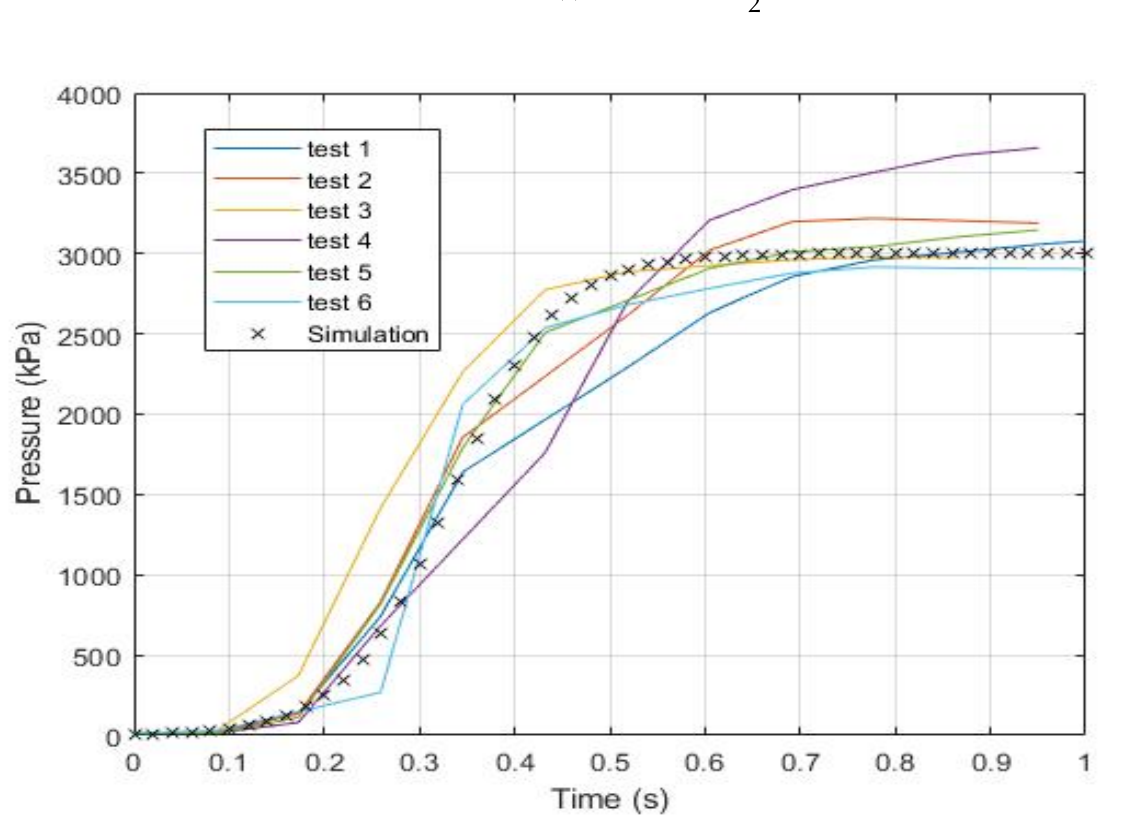
Figure 2. Brake pressure over time for a rider performing an emergency stop. Data points labeled “Simulation” show the hyperbolic tangent curve fit. Table 2. Values selected for each variable used in the bicycle longitudinal dynamics and bicycle tire simulation blocks during corroboration tests.